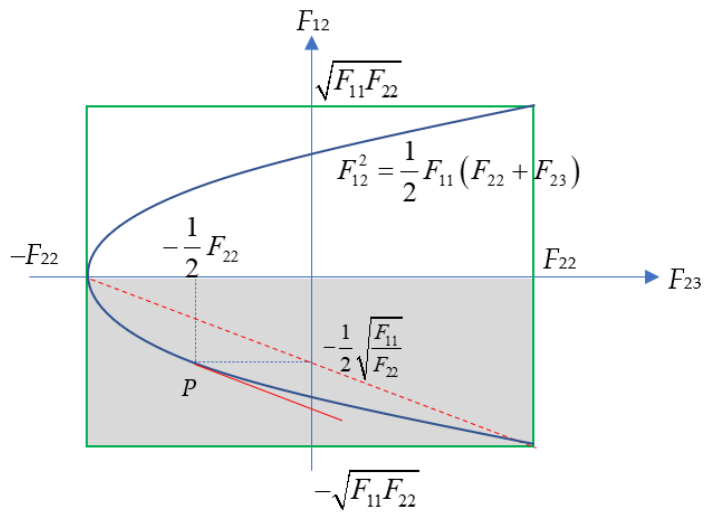
Figure 1. The relationship between F 12 and F 23 and their permissible